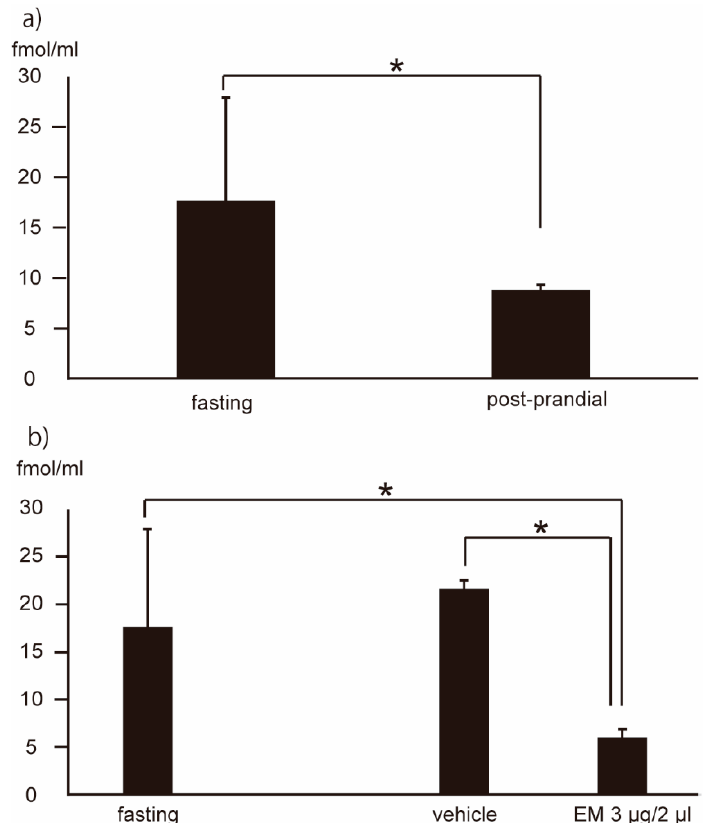
Figure 7. Plasma levels of acyl-ghrelin in fasting and post-prandial state ( a ), and 1 h following central (intracerebroventricular) administration of EM ( n = 4) or vehicle ( n = 3) ( b ). Values represent the mean ± SD for the indicated number of animals. * p < 0.05 (Unpaired Student’s t -test, One-way ANOVA with Tukey post-hoc test).